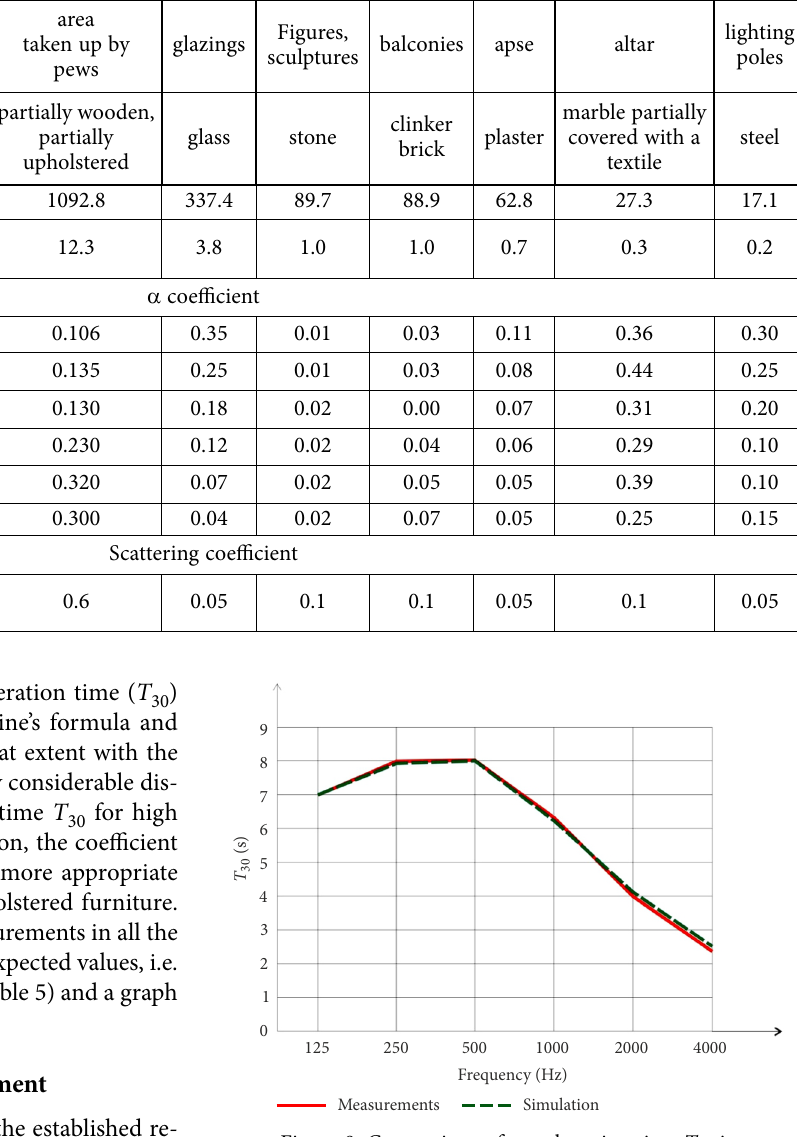
Figure 8. Comparison of reverberation time T 30 in the frequency function for in situ investigations and an ODEON computer